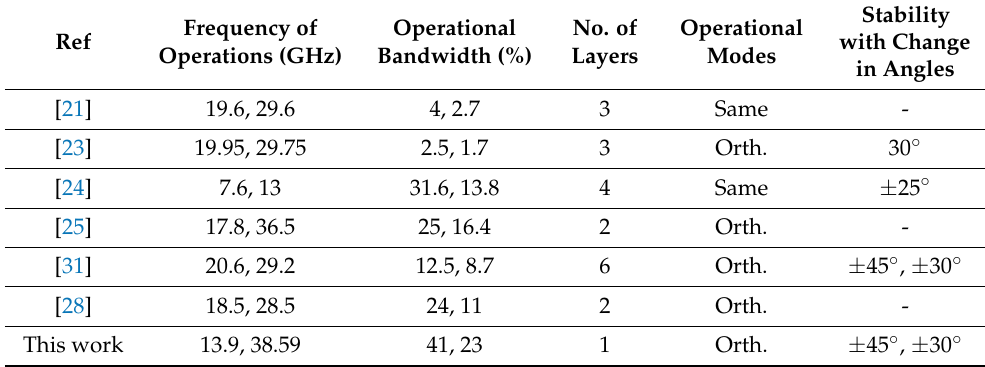
Table 2. Performance comparison with other state-of-the-art dual-band polarization converters (LC-to-CPs). Stability Frequency of Operational No. of Operational with Change Ref Operations (GHz) Bandwidth (%) Layers Modes in Angles [21] 19.6, 29.6 4, 2.7 3 Same - [23] 19.95, 29.75 2.5, 1.7 3 Orth. 30 ◦ [24] 7.6, 13 31.6, 13.8 4 Same ± 25 ◦ [25] 17.8, 36.5 25, 16.4 2 Orth. - [31] 20.6, 29.2 12.5, 8.7 6 Orth. ± 45 ◦ , ± 30 ◦ [28] 18.5, 28.5 24, 11 2 Orth. - This work 13.9, 38.59 41, 23 1 Orth. ± 45 ◦ , ± 30